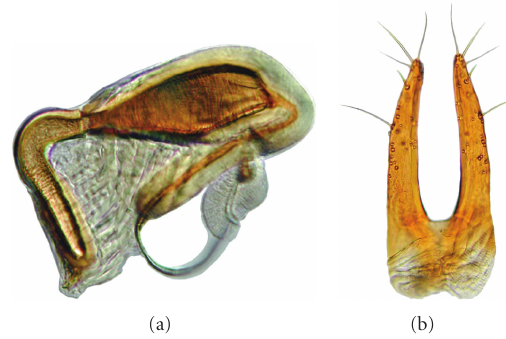
Figure 3: Neocrepidodera ferruginea , female genitalia: (a) spermath- eca; (b) styli (vaginal palpi).